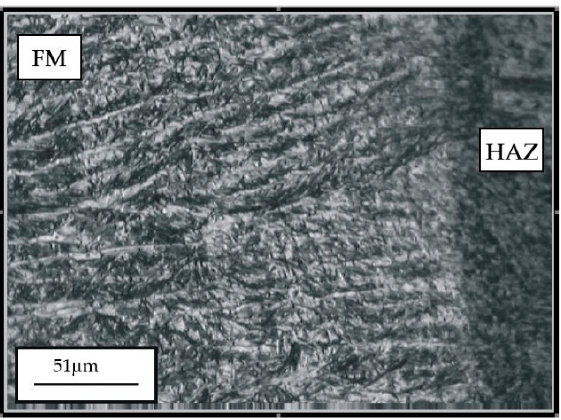
Figure 6. Appearance of microstructure of the hard-faced sample obtained by the Castolin 2 filler metal at the transition between the hard-faced layer and the heat-affected zone.